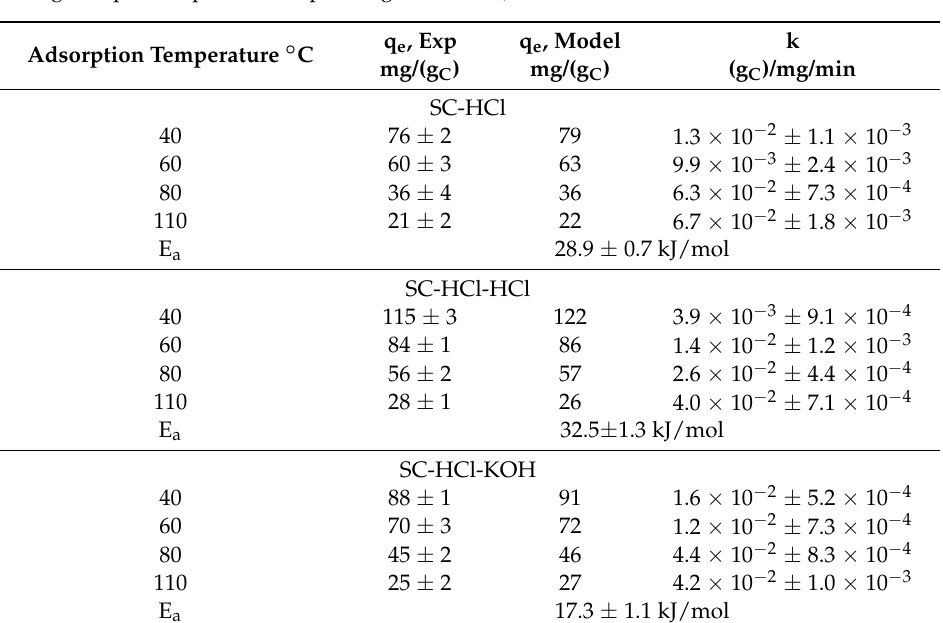
Table 3. Rate constants and activation energies for pseudo-second-order kinetics of adsorption of SO 2 onto demineralized samples (experimental values ± 1 standard deviation) (used in computational modeling to represent pilot scale operating